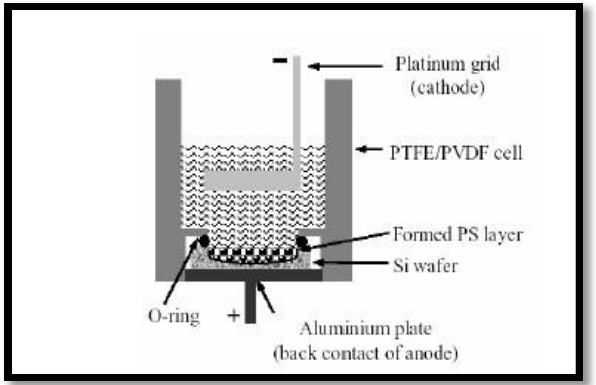
Figure 1: The schematic diagram of experimental step for preparing n-PS layer vertical